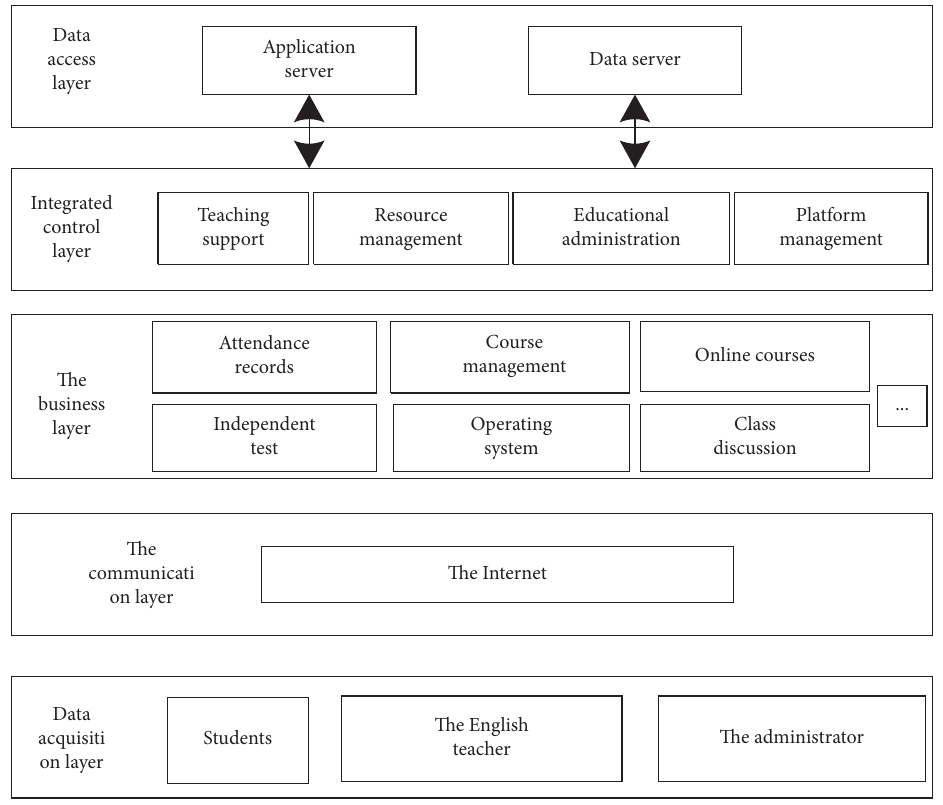
Figure 1: The overall structure of the Internet-based online tutoring platform of college English teaching.